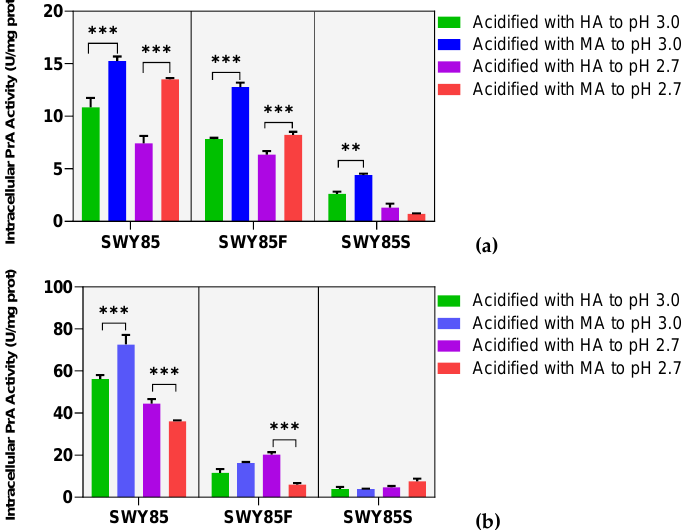
Figure 3. The iPrA activity of the three strains. Cells were cultured under acid stresses with adequate nutrients ( a ) and amino acid starvation ( b ). HA, Hydrochloric acid; MA, Malic acid. ** p < 0.01, *** p <